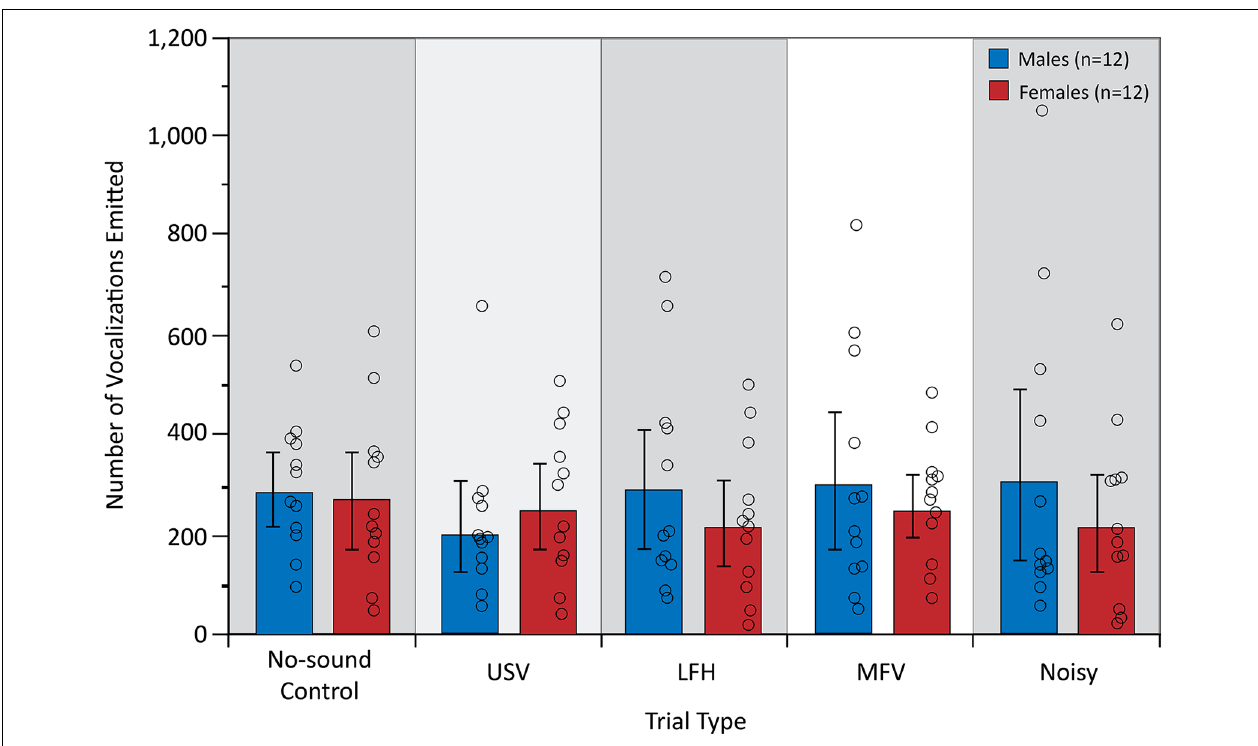
FIGURE 6 | The total number of vocalizations emitted during the first 10 min after stimulus onset. There were no significant differences in vocalizations for trial type. For symbols, see Figure 4